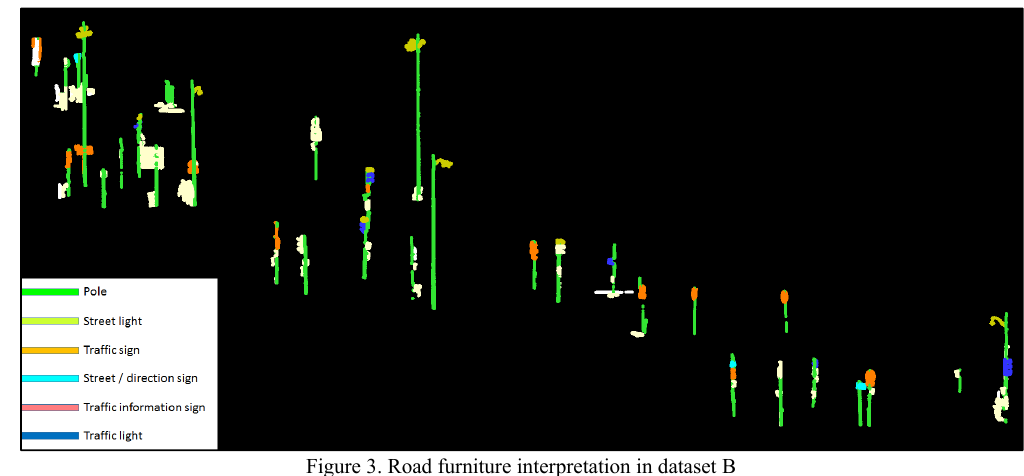
Figure 3. Road furniture interpretation in dataset B